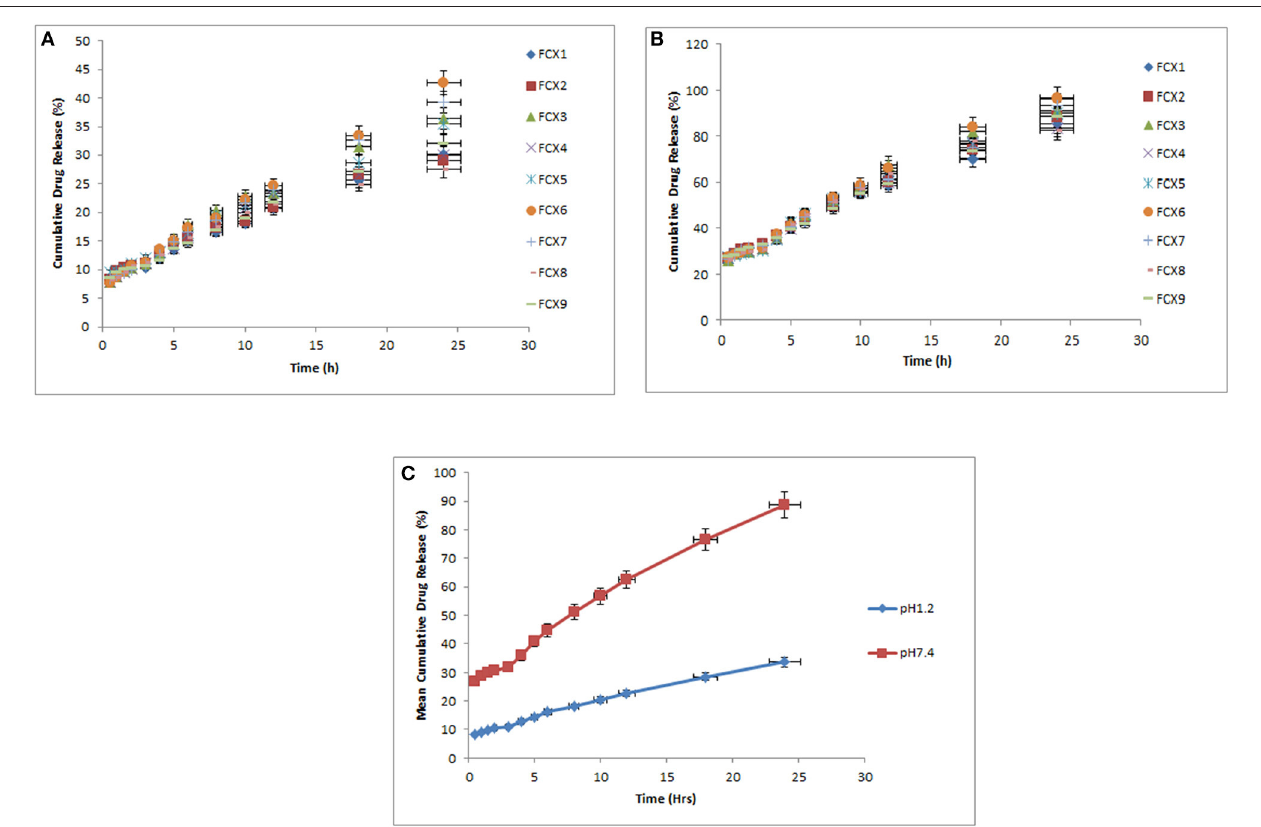
FIGURE 9 | Mean cumulative drug releases of hydrogels (FCX1 to FCX9) at pH 1.2 and pH 7.4. (A) Cumulative drug release of hydrogels (FCX1–FCX9) at pH 1.2. (B) Cumulative drug release of hydrogels (FCX1–FCX9) at pH 7.4. (C) Mean cumulative drug release of hydrogels (FCX1–FCX9) at pH 1.2 and pH 7.4.